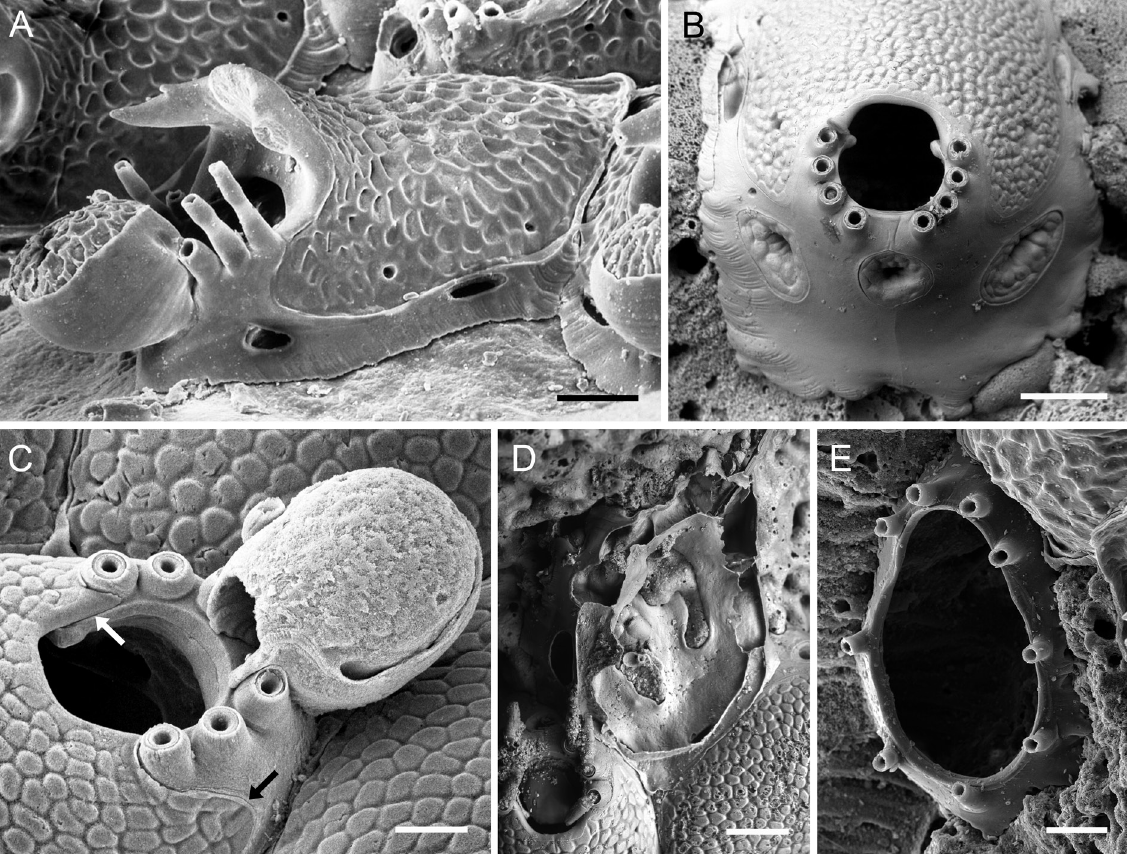
Fig. 1. Morphological characteristics of Atlantisina gen. nov. A . The kenozooidal ooecium of Atlantisina lionensis gen. et sp. nov. in lateral view (paratype MNHN-IB-2014-67), showing the broad band of ectooecium and the centrally exposed endooecium; note that the suboral crest is formed by smooth gymnocyst whereas the remaining frontal shield is cryptocystidean. B . Distal view of an autozooid of Atlantisina meteor gen. et sp. nov. showing two distolateral communication pores and the slightly raised central pore from which the ooecium is budded (paratype MNHN-IB-2014-50); note the broad band of cryptocyst bounding the septular pores, and that the remaining parts of the distolateral vertical walls and orifice are entirely gymnocystal. C . Oral region of an ovicellate zooid of Atlantisina atlantis gen. et sp. nov. (paratype MNHN-IB-2014-49), showing the contact between the cryptocystidean frontal shield and the gymnocystal distal part of the zooecium; note that the frontal shield is superpositioned on the condyles (white arrow) and meets the distolateral vertical walls in a sinusoidal suture (black arrow). D . Initial stages of zooid formation with the lateral walls being partly broken, showing the large basal pore chambers in Atlantisina atlantis gen. et sp. nov. (paratype OLL 2016/123). E . Slightly oblique view of the ancestrula of Atlantisina tricornis gen. et sp. nov. (paratype MNHN-IB-2014-64); note the simple tatiform morphology, the absence of a cryptocyst, and the slightly restricted oral region (top). Scale bars: A–B, D = 100 µm; C, E = 50